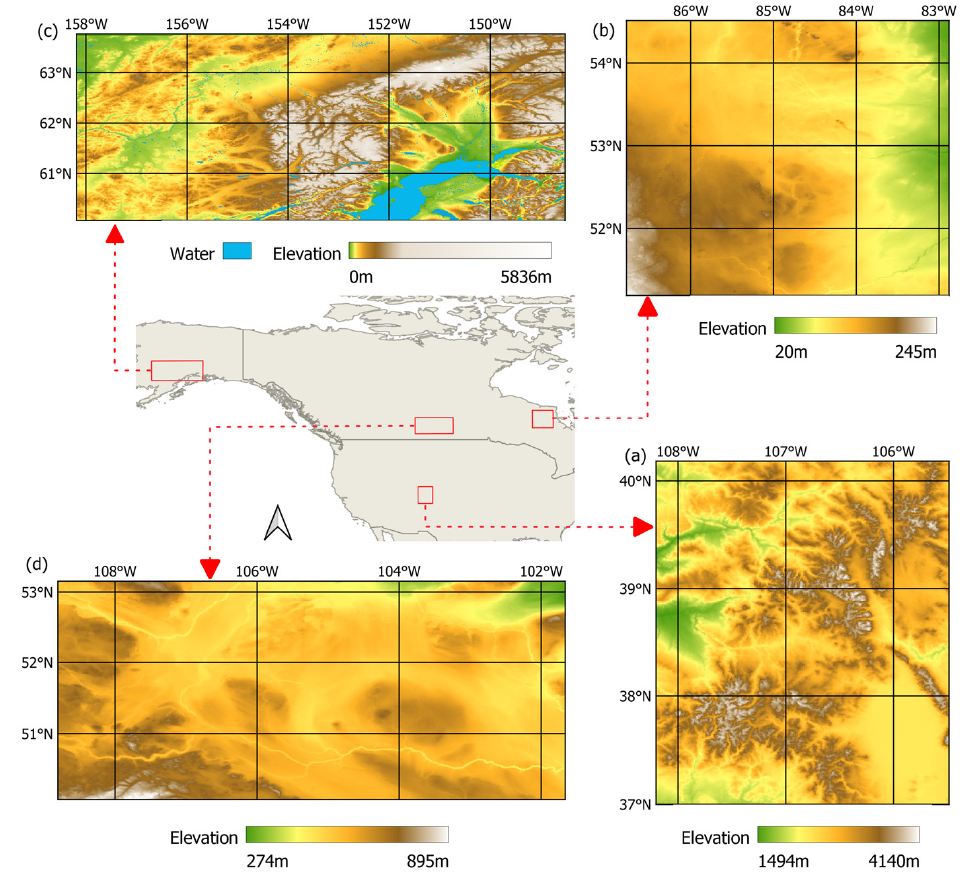
Figure 1. Locations of case study areas: Colorado, USA ( a ); Ontario, Canada ( b ); Alaska, USA ( c ); Saskatchewan, Canada ( d ).